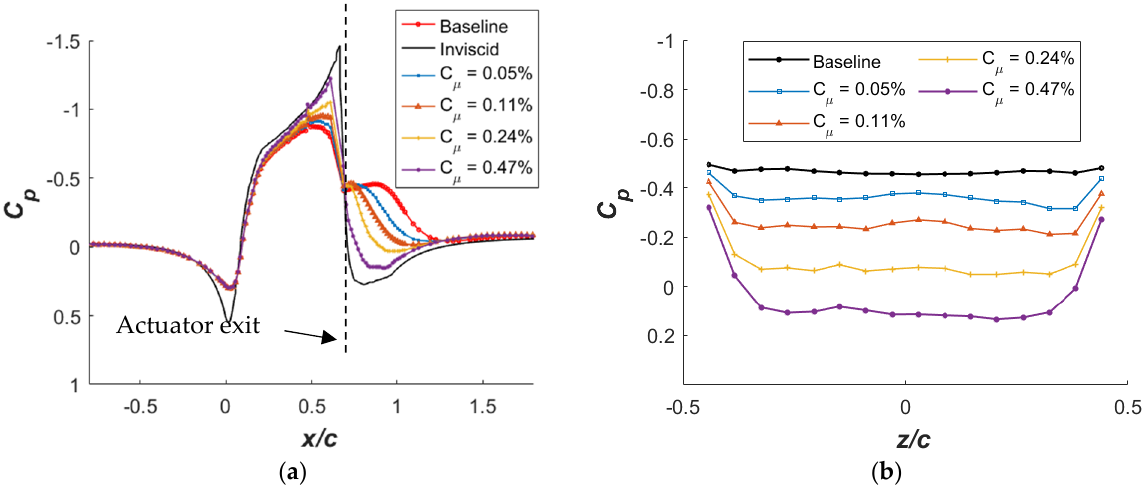
Figure 5. Surface static pressure distribution over the hump model for different momentum coefficients: ( a ) centerline pressure distribution; ( b ) spanwise pressure distribution near the trailing edge of the model.